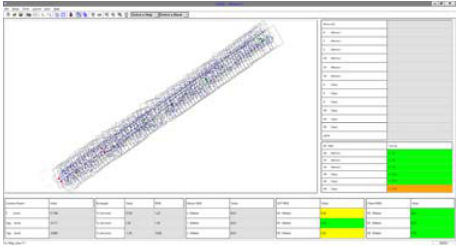
Figure 7: CalQC bundle adjustment project – Railway